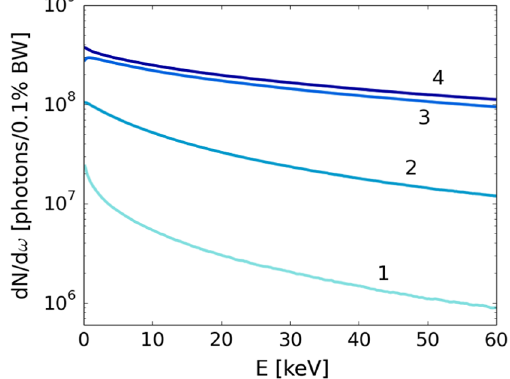
FIG. 7. Photon distribution per 0.1%BW integrated over a 100 × 100 mrad 2 angle, obtained in the SM-LWFA regime. From lighter to darker blue: (1) n